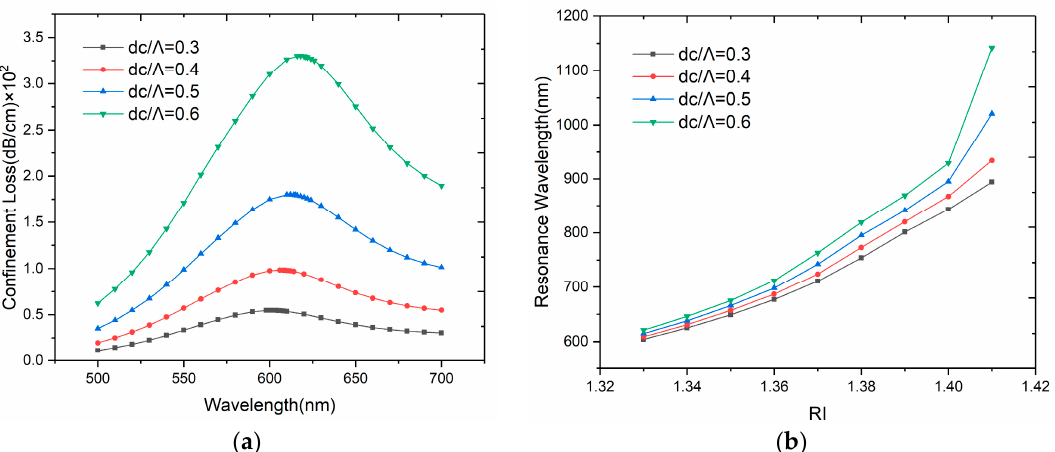
Figure 5. ( a ) Loss spectra of the designed sensor when d c / Λ = 0.3, 0.4, 0.5 and 0.6 with n a = 1.33; ( b ) Relationship between resonance wavelength and RI when d c / Λ = 0.3, 0.4, 0.5 and 0.6 in the range of n a from 1.33 to 1.41.